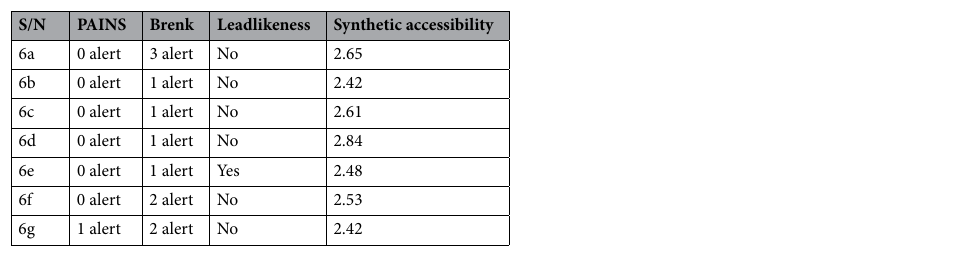
Table 6. Medicinal chemistry.